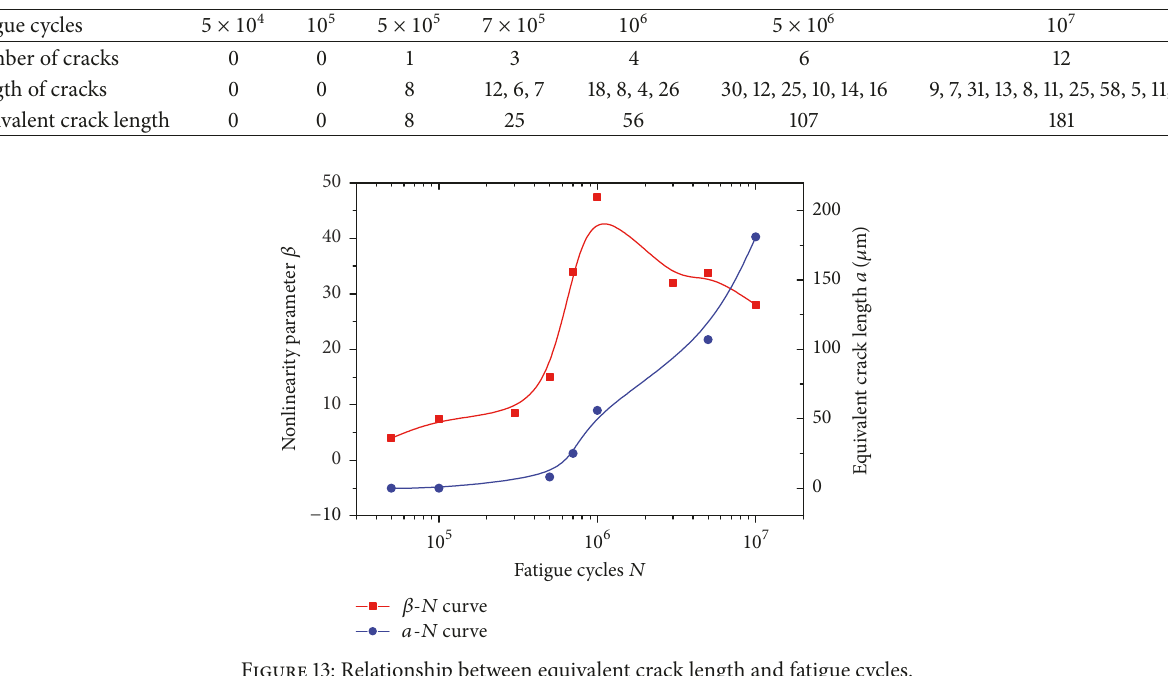
Figure 13: Relationship between equivalent crack length and fatigue cycles.